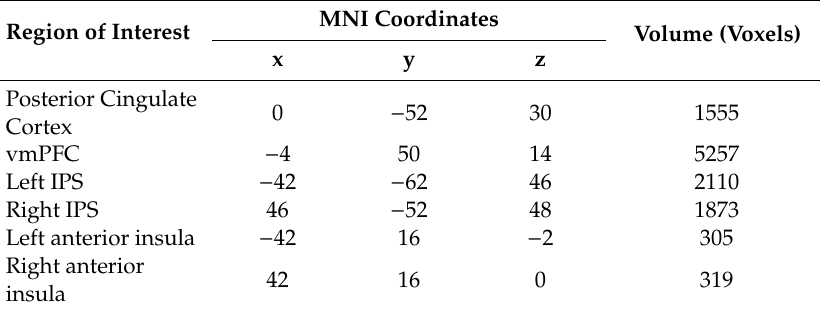
Figure 1. Regions of interest (ROIs) used as seeds. In red the posterior cingulate cortex and ventromedial cortex from the default mode network (A = anterior, L = left, R = right, P = posterior). In orange, the left and right intraparietal sulcus from the central executive network. In blue, the left and right anterior insula from the salience network. These ROIs were taken from published resting state networks [41]. Table 1. Coordinates and volume for the included regions of